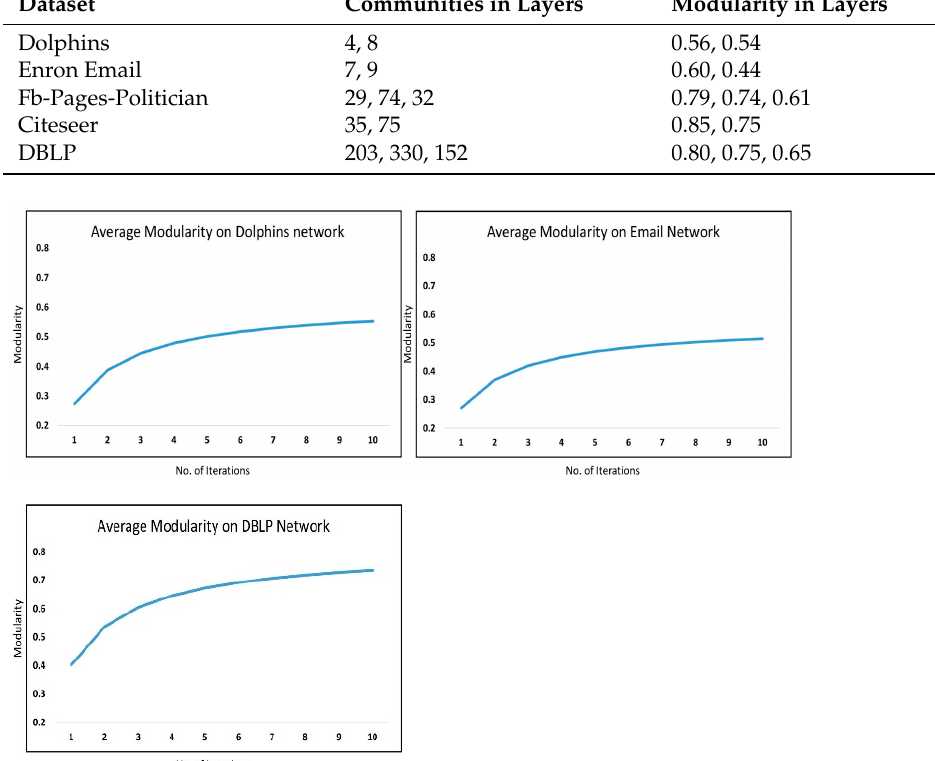
Figure 5. Results of improvements in modularity scores of different graphs in each iteration. The vertical axis shows the modularity values and the horizontal axis is for the number of iterations.